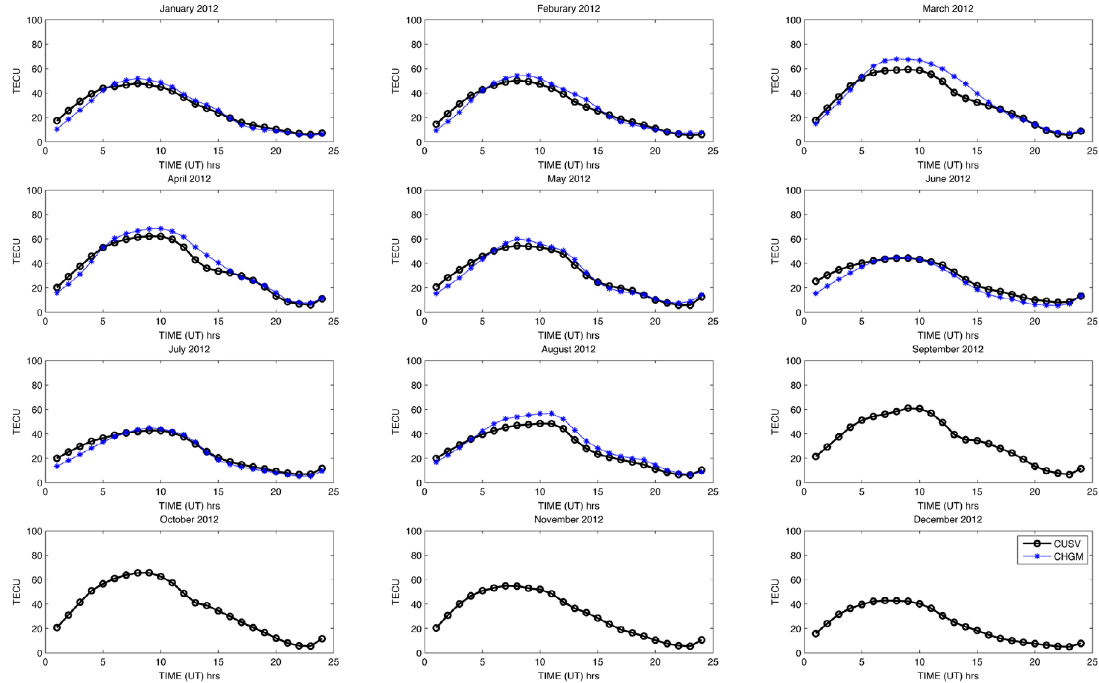
Figure 11. Comparison of monthly variations of mean GPS TEC values at CHGM and CUSV stations during the period